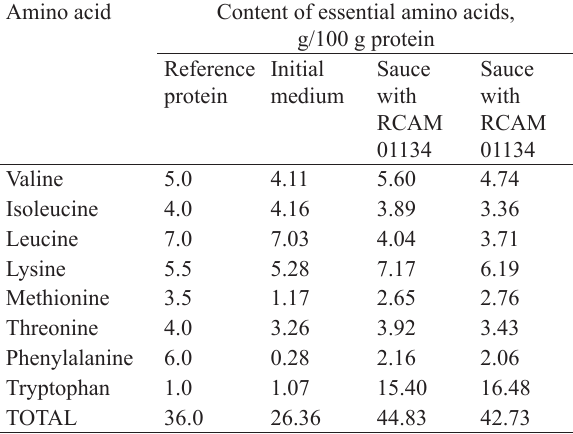
Table 1 Essential amino acid contents in the initial soy material and fermented sauces vs. reference protein Content of essential amino acids,